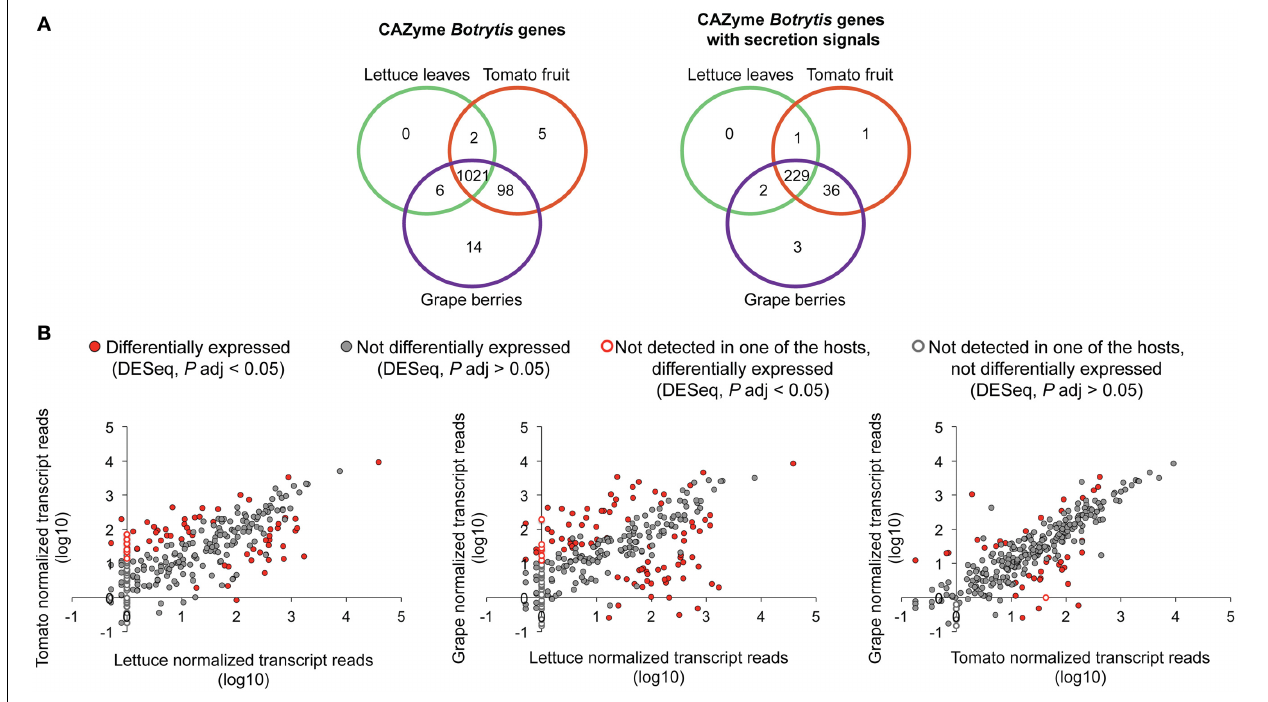
FIGURE 2 | Comparisons of CAZyme gene expression during infections of lettuce leaves, tomato fruit and grape berries. (A) Venn diagrams showing the overlapping and unique sets of CAZyme Botrytis genes (left) and CAZyme Botrytis genes with potential signal peptides